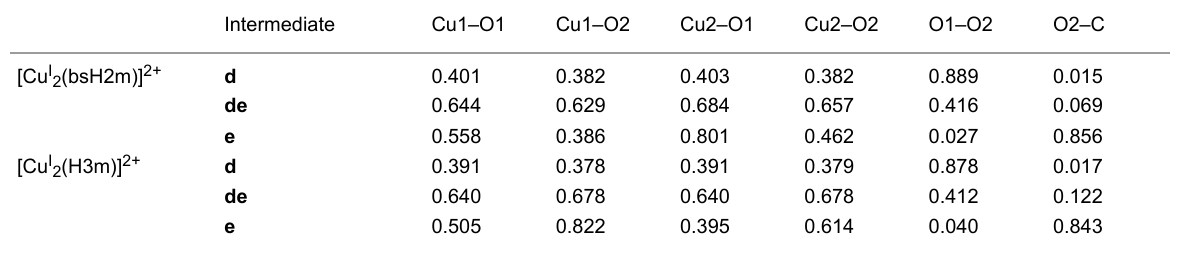
Table 1: MBOs for d → e step for the [Cu I 2 (H3m)] 2+ and the [Cu I 2 (bsH2m)] 2+